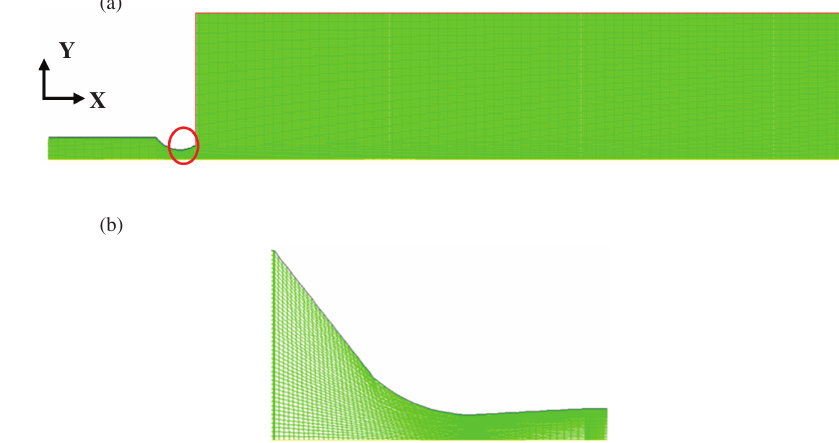
Figure 3: Grid of geometry region (a) grid of computational region (b) grid of the